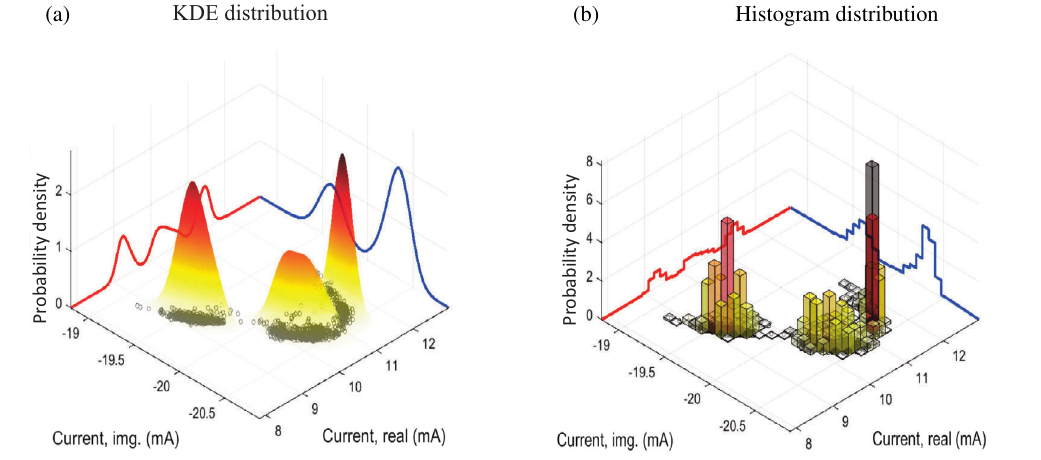
Fig. 3. KDE and histogram distributions applied to the 5th harmonic current of the PC